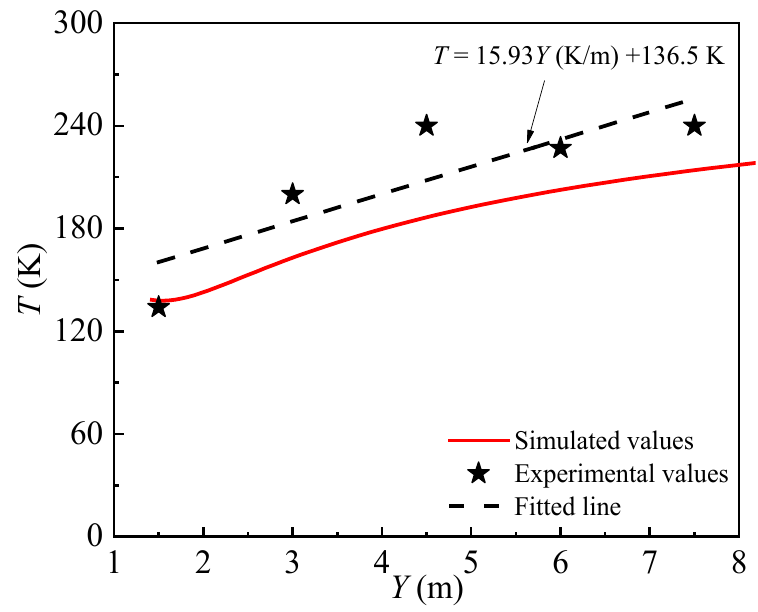
Figure 5. Numerical vs. experimental temperature variation.